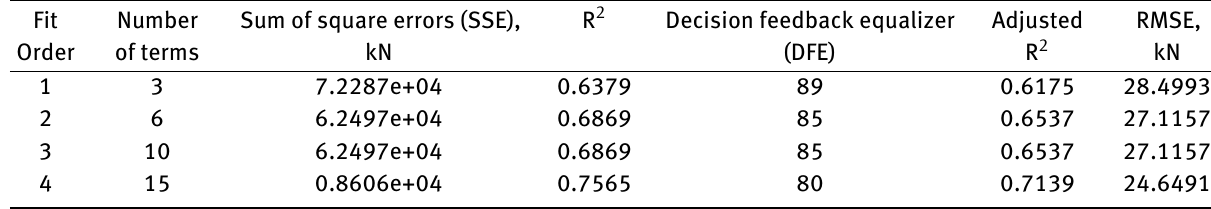
Table 3: Parameters of suggested polynomials were used to determine the allowable bearing capacity of 6 m length driven piles Fit Order